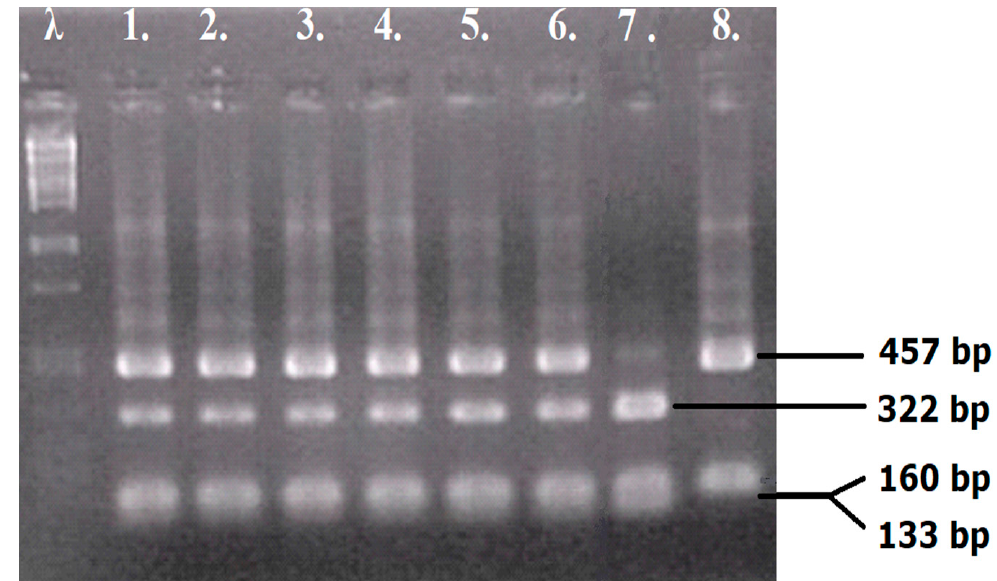
Figure 1. The analysis of 26S rRNA Hae III restriction polymorphisms of constructed hybrids (1( Hyb1ACO1 ), 2( Hyb2ACO1 ), 3( Hyb1KGD1 ), 4( Hyb2KGD1 ), 5( Hyb1CIT1 ), 6( Hyb2CIT1 )) and parental strains 7( S. cerevisiae, CIT1 ) and 8( S. mikatae, Sm ). λ ( λ / Pst I) were used as the ladder.